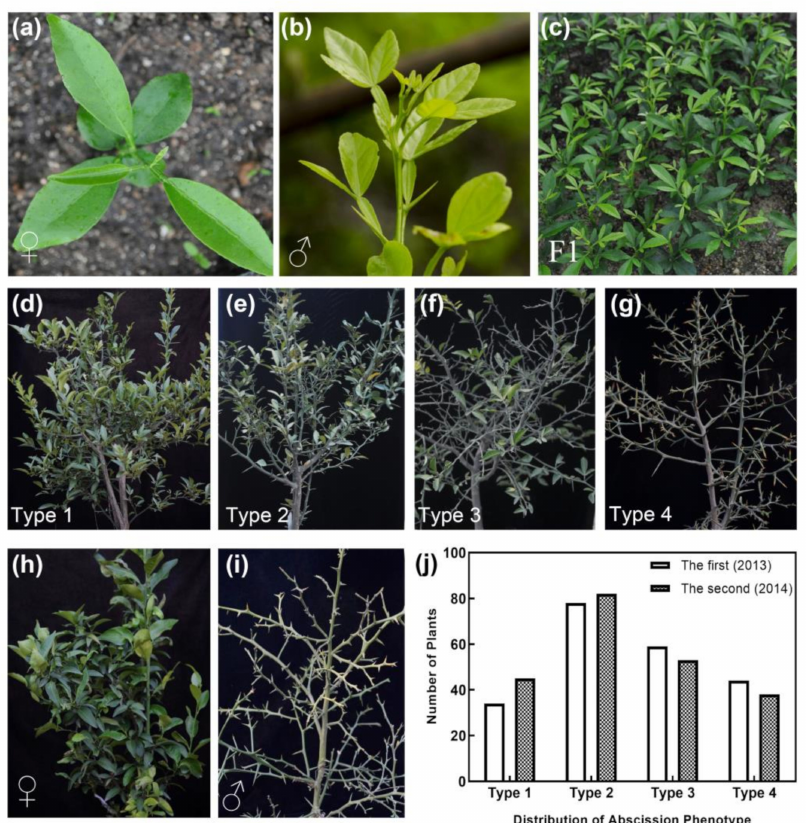
Figure 2. Hybrid population construction. ( a ) Clementine mandarin (female parent) at the seedling stage. ( b ) Trifoliate orange (male parent) at the seedling stage. ( c ) F1 hybrid population at the seedling stage. ( d ) Hybrids with no leaf abscission phenotype (Type 1). ( e ) Hybrids with slight leaf abscission phenotype (Type 2). ( f ) Hybrids with a severe leaf abscission phenotype (Type 3). ( g ) Hybrids with all leaves dropped (Type 4). ( h ) The evergreen phenotype of the female parent (clementine mandarin). ( i ) The deciduous phenotype of the male parent (trifoliate orange). ( j ) The statistics data of the leaf abscission phenotype variation of progeny type 1 to type 4 represent the ( d ) to ( g ) different phenotypes,